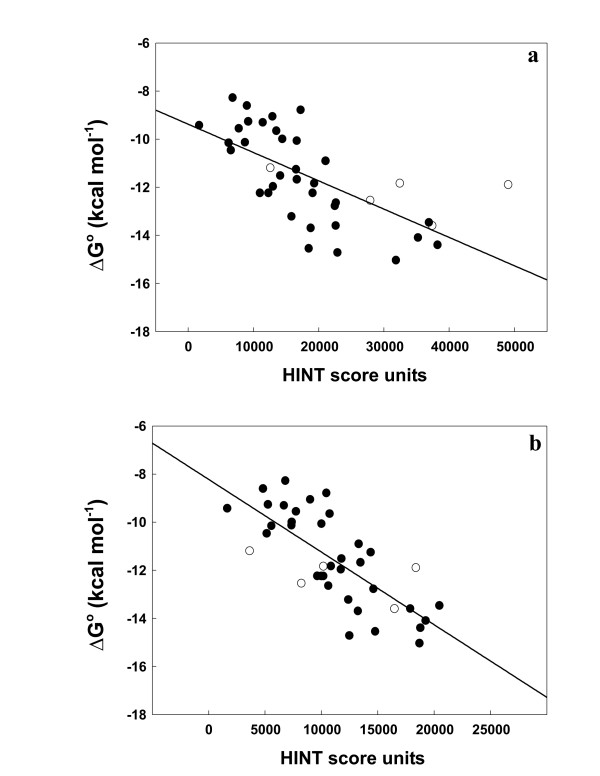
Correlation between the experimental binding free energies and the calculated HINT score values taking into account the score contributions of water molecules. a) Including all water molecules within in a 4 Å range of both atoms of the protein and atoms of the DNA. b) Including waters in a 4 Å range with total Rank ≥ 4, and non-zero partial Ranks with both protein and DNA.